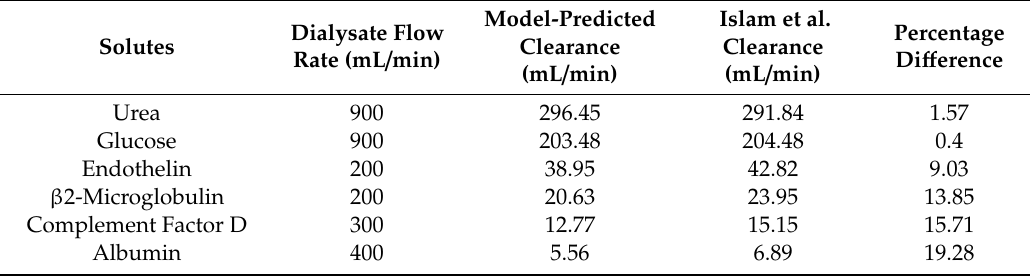
Figure 8. The model predicted (solid lines) vs. in vivo and silico (symbols) solute clearances plotted against varying dialysate flow rate at Q B = 400 mL/min. Table 5. Maximum percentage difference of this model with literature data at varying dialysate flow rate [22].